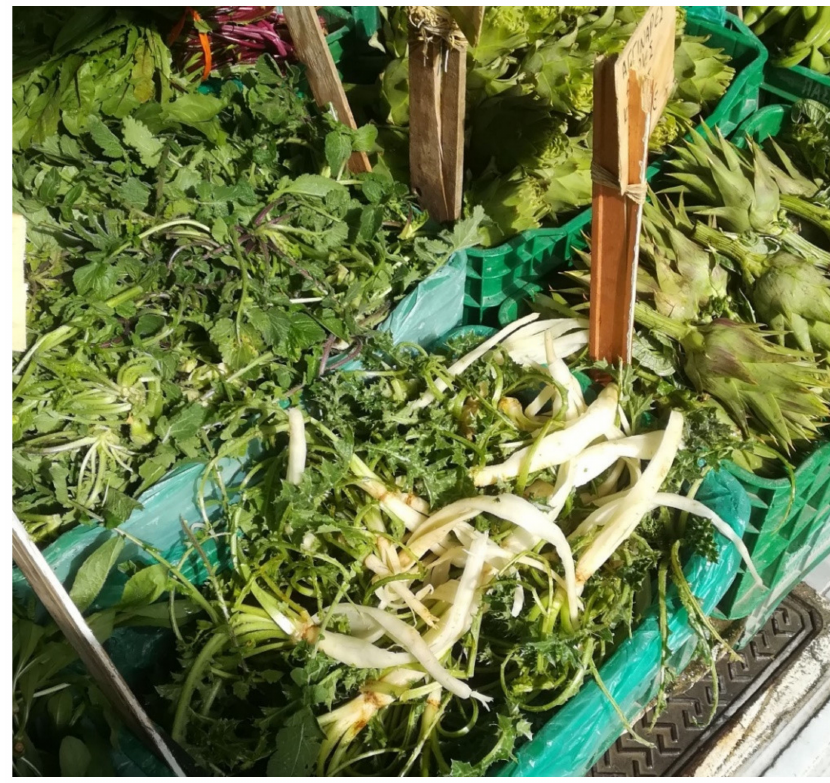
Figure 8. Chorta in a vegetable market in